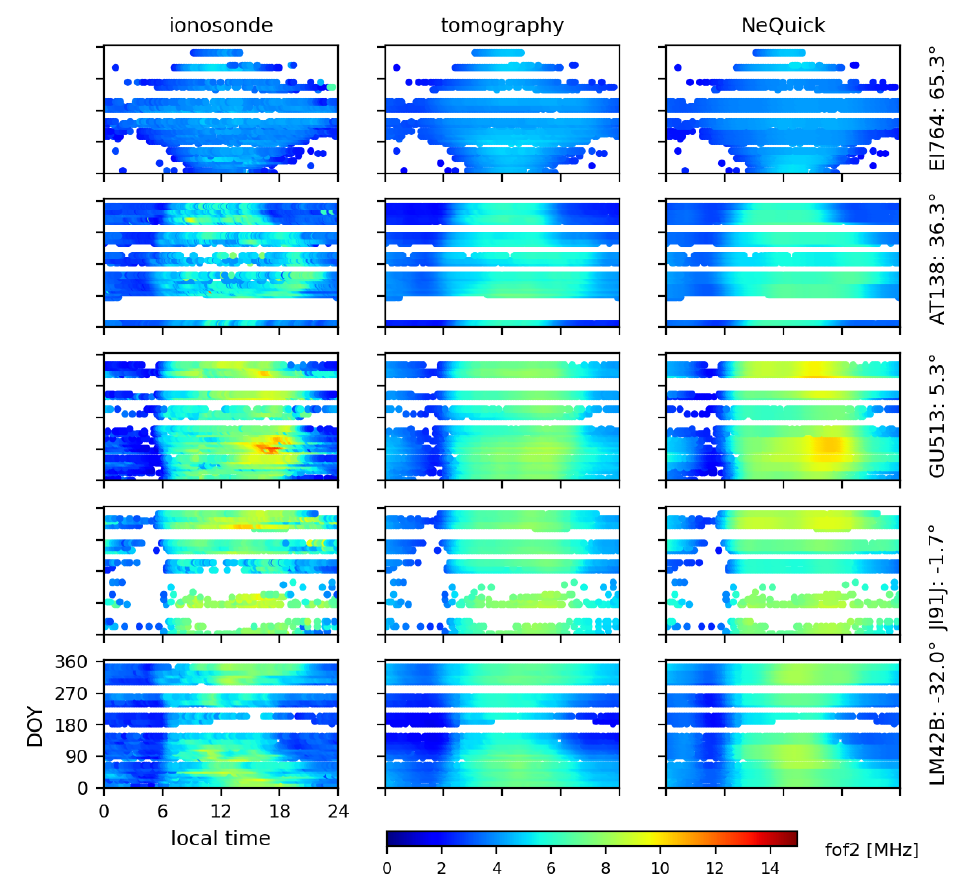
Figure 5. Critical frequency estimated in five ionosonde locations using GIRO dataset ( left ), tomog- raphy ( middle ) and NeQuick ( right ) in terms of local time and day of year of 2018. White spaces represent lack of